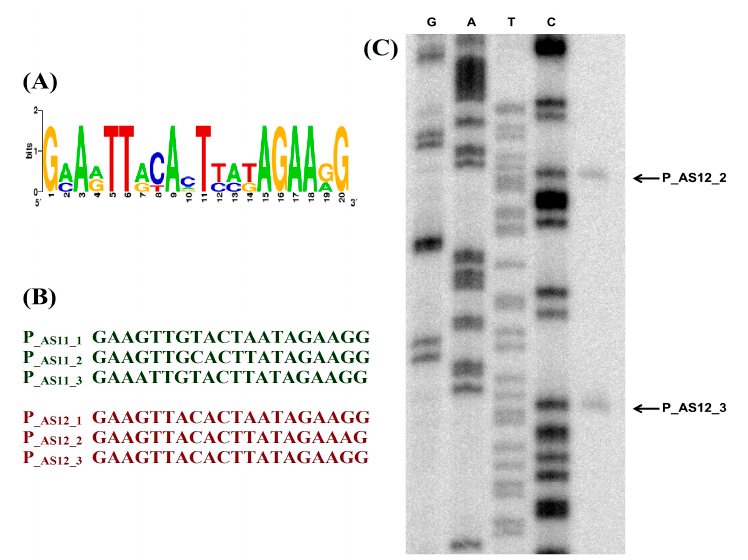
Figure 6. Identification of AS11 and AS12 phage-encoded T7-type RNAP promoters: ( A ) A logo representation of putative promoter consensus sequence for phages AS11 and AS12; ( B ) Sequences of phage-encoded promoters validated by primer extension analysis; ( C ) Example of in vitro promoter mapping. The products of sequencing reactions, performed with the same end-labelled primers and appropriate PCR fragment as a template were run alongside primer extension reactions.